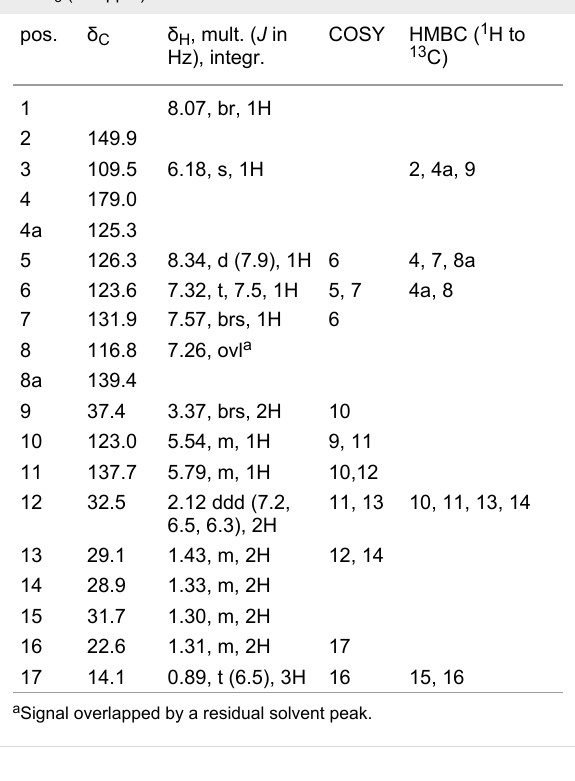
Table 1: NMR data for ( E )-2-(non-2-en-1-yl)quinolin-4(1 H )-one ( 3 ) in CDCl 3 ( δ in ppm).